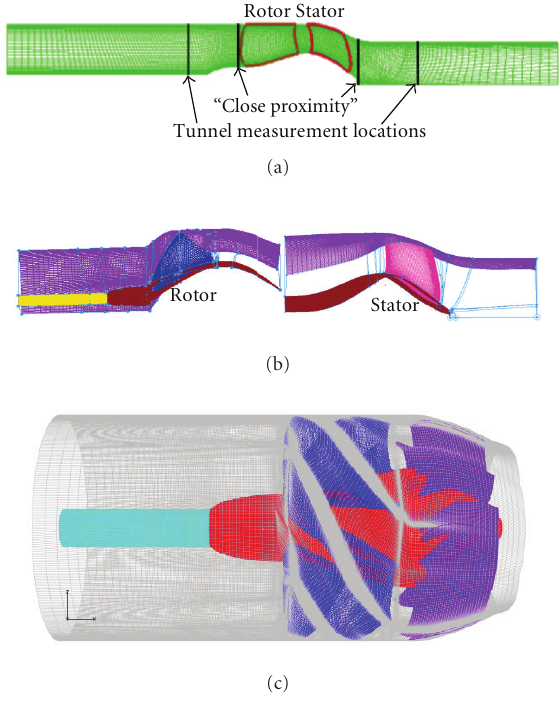
Figure 1: Waterjet pump, AxWJ-2, computational grids shown on all solid surfaces. (a) Axisymmetric through-flow grids with “measurement” locations illustrated. (b) Periodic 3D rotor, and 3D-stator grids. (c) 3D grids assembled, repeated, and overlaid for illustration. In part (c), shaft is light blue, hub is red, rotor blades are dark blue, stator blades are purple, and shroud/duct is gray.